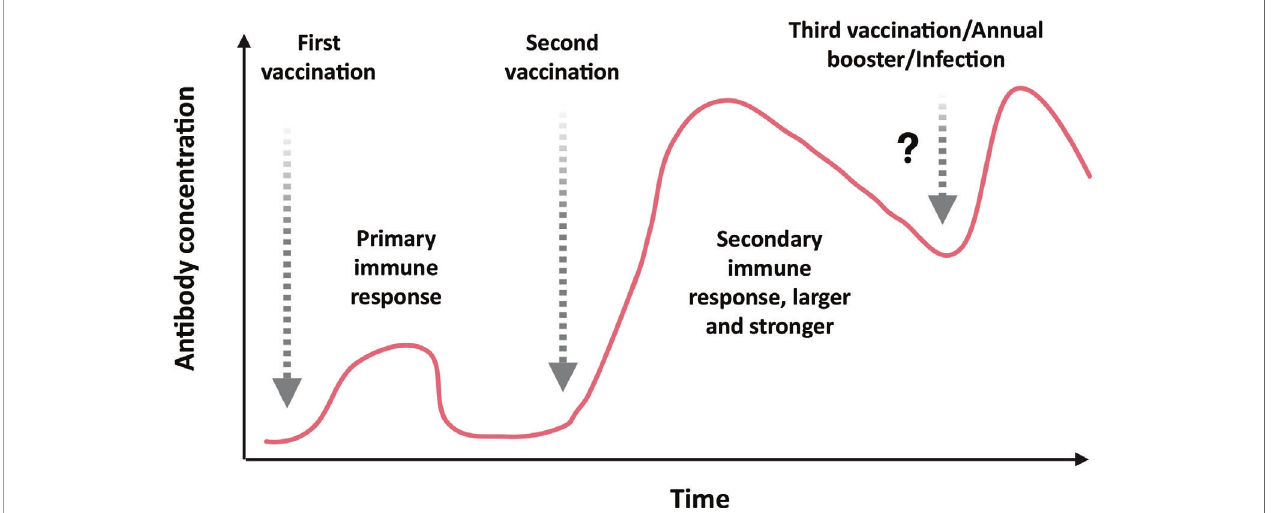
FIGURE 5 | Antibody response to fi rst, second, and probable third/annual booster dose of COVID-19 vaccination or infection: Initially, just after the fi rst immunization, the vaccine does not elicit suf fi cient neutralizing antibody to prevent the infection of SARS-CoV-2. Upon administration of the second booster dose of vaccine, the vaccine elicits a stronger neutralizing antibody response with high titer that could prevent the infection ef fi ciently. In some cases, third or annual boosters are required to revive the immune response against the